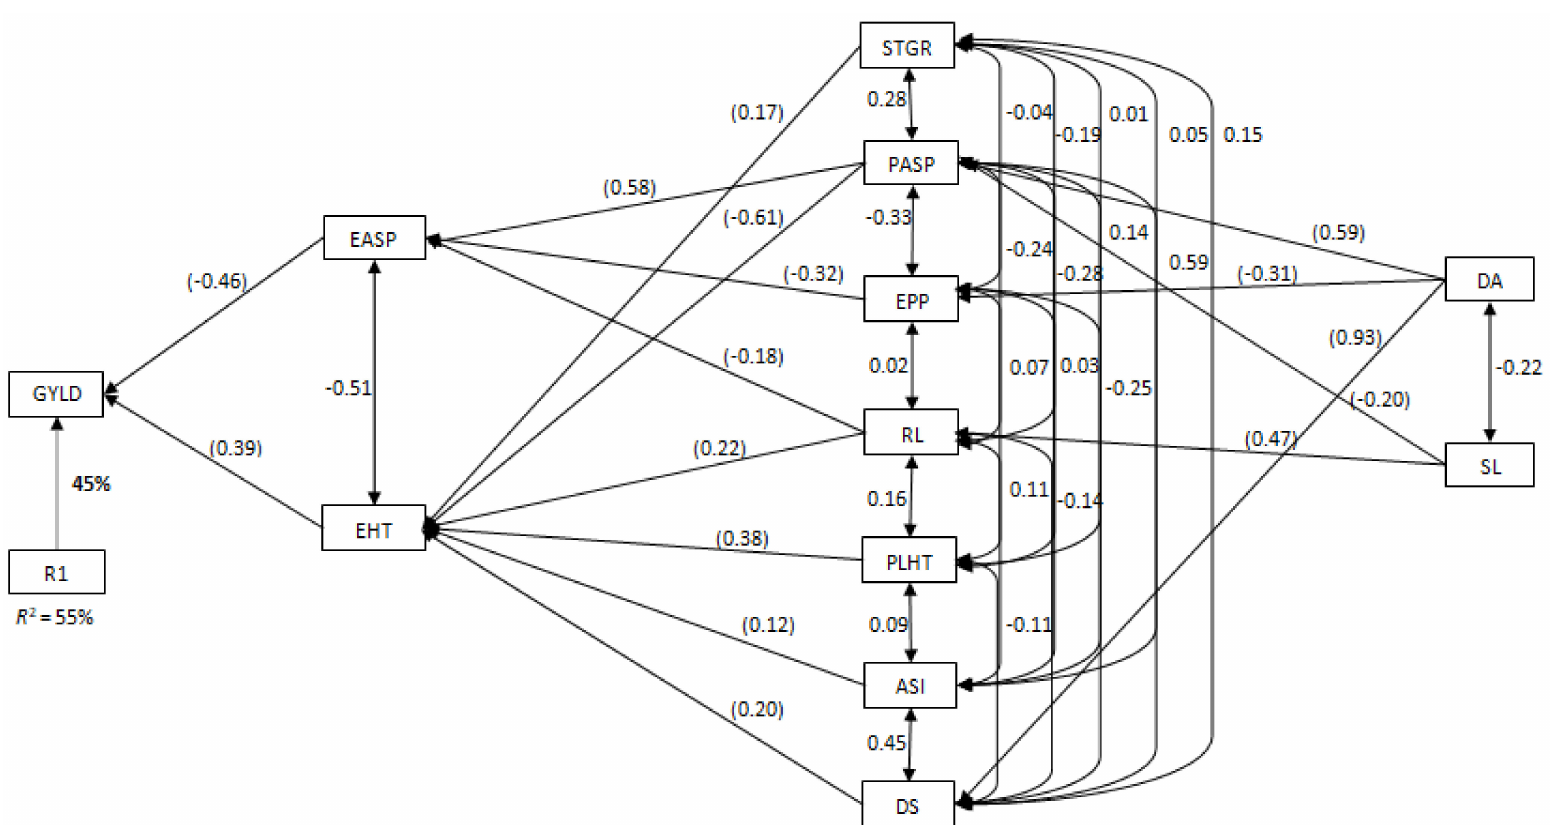
Figure 5. Path analysis diagram showing inter-trait relationships of traits of early QPM hybrids evaluated across test environments in Nigeria. Bold value is the residual effect; direct path coefficients values in parenthesis while correlation coefficients are the other values. R 2 = coefficient of determination; R1= residual effects; GYLD = Grain yield; ASI = anthesis-silking interval; PASP = plant aspect; PLHT = plant height; EASP = ear aspect; EHT = ear height; EPP = ears per plot; STGR = stay green characteristic; DA= days to 50% anthesis; RL = root lodging; DS = days to 50% silking; SL = stalk lodging; TABLAST= tassel